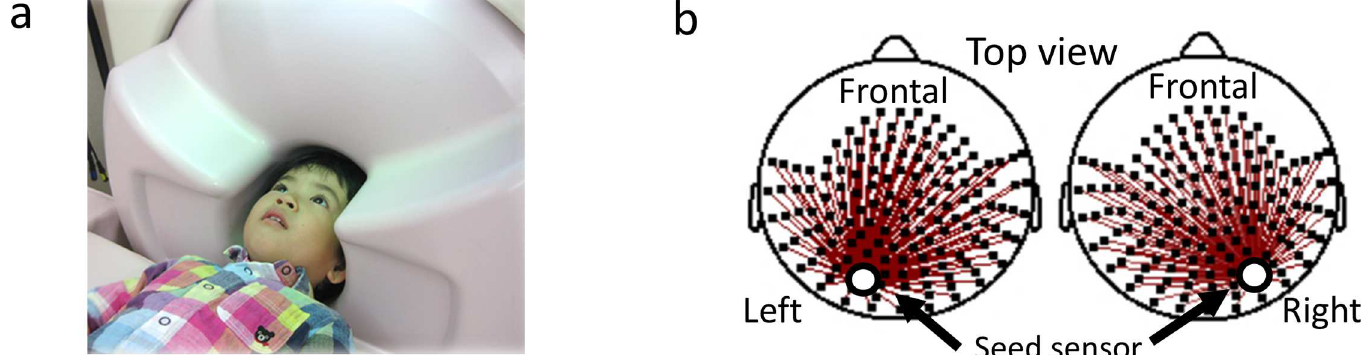
Fig 1. The customchild-sized MEG systemand the sensorlevel connectivityanalysis. (a) In the customchild-sized MEG system,the MEG sensorsare as close to the whole head as possible for optimalrecordingin young children.DuringMEG recording,the childrenlay supine on the bed and viewed video programsprojectedonto a screen.(b) We calculatedImCohvalues between the seed sensor (whitecircle)and the other146 sensors (redlines).